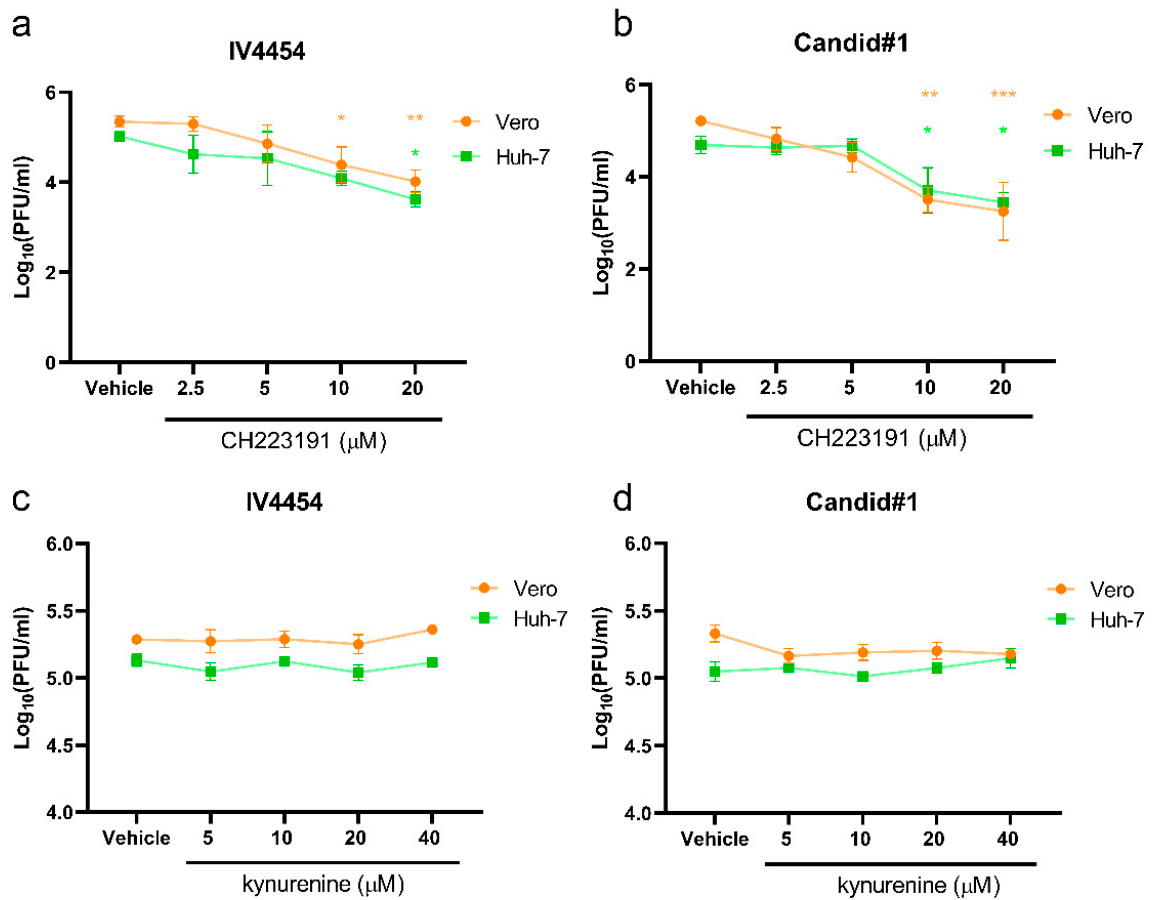
Figure 3. Viral yield determination through standard plaque assay of JUNV-infected cells treated with AHR ligands. Cell cultures were pre-treated with either CH223191 ( a , b ) or kynurenine ( c , d ). Subsequently, cells were either mock infected or infected with JUNV strains IV4454 ( a , c ) or Candid#1 ( b , d ). Supernatants were collected at 48 h pi. Data represent the mean ± SD. Statistical analysis was performed by comparing treatments with vehicle control. p < 0.05 was considered statistically significant. * p < 0.05; ** p < 0.01; *** p < 0.001.